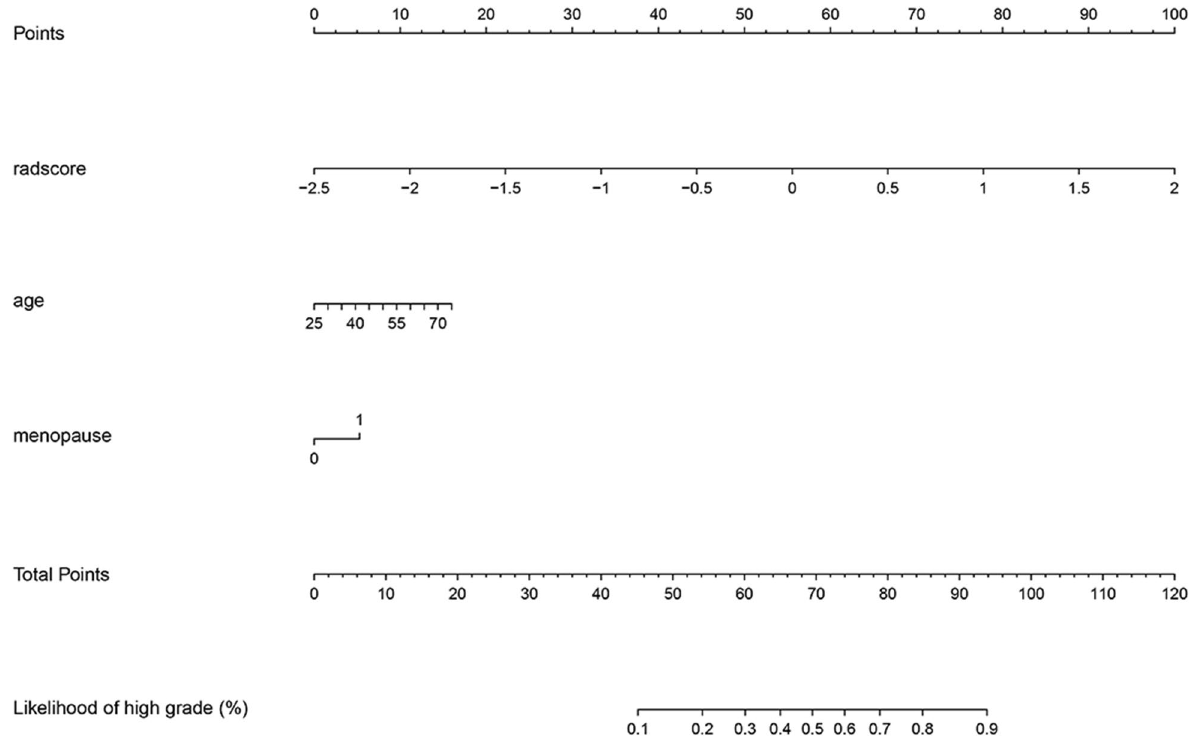
Fig. 4 The nomogram based on the rad-scores, age, and menopausal status